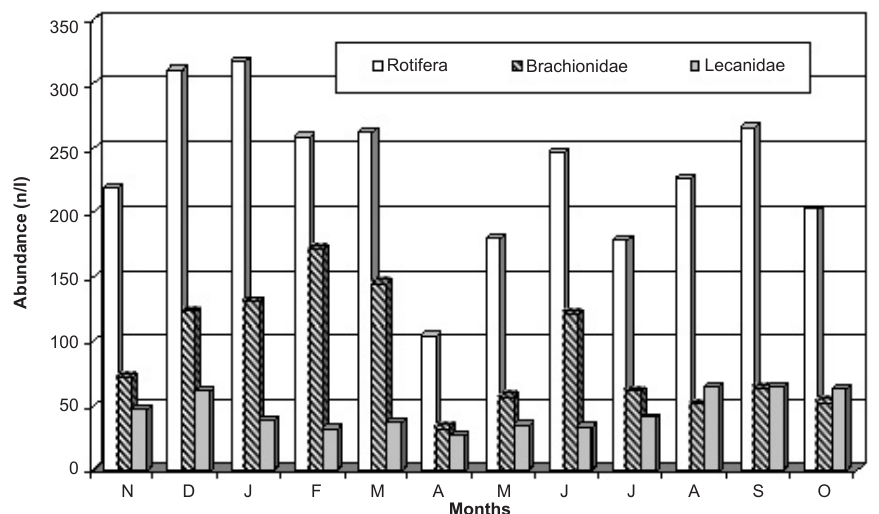
Figure 4. Monthly variations in abundance of Rotifera and important families (Station I)